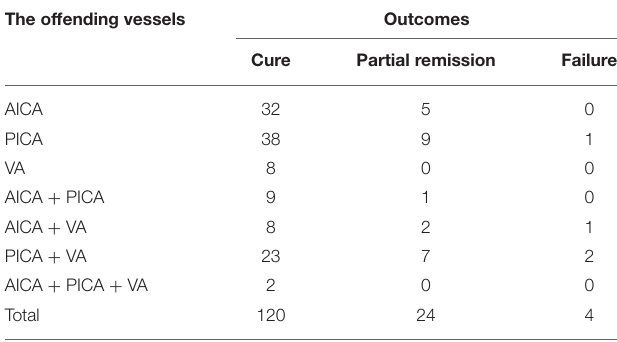
TABLE 3 | Clinical outcomes of patients who underwent keyhole microvascular decompression (MVD) for hemifacial spasm